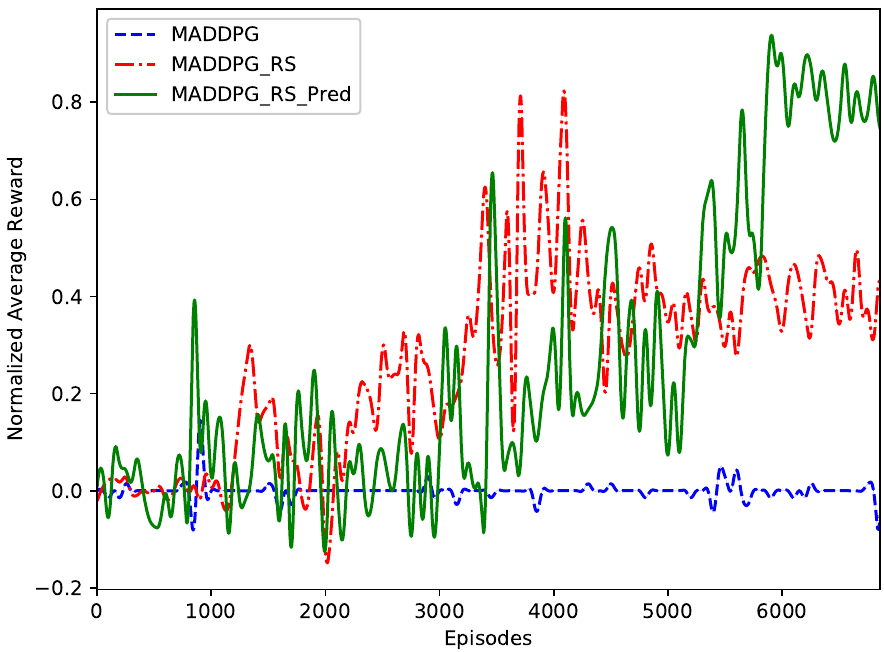
Figure 7. Curve of the normalized average reward of MADDPG (basic MADDPG algorithm), RS-MADDPG (MADDPG algorithm with only reward shaping), and PRED-RS-MADDPG (the MADDPG algorithm with reward shaping and prediction of the target position) with the